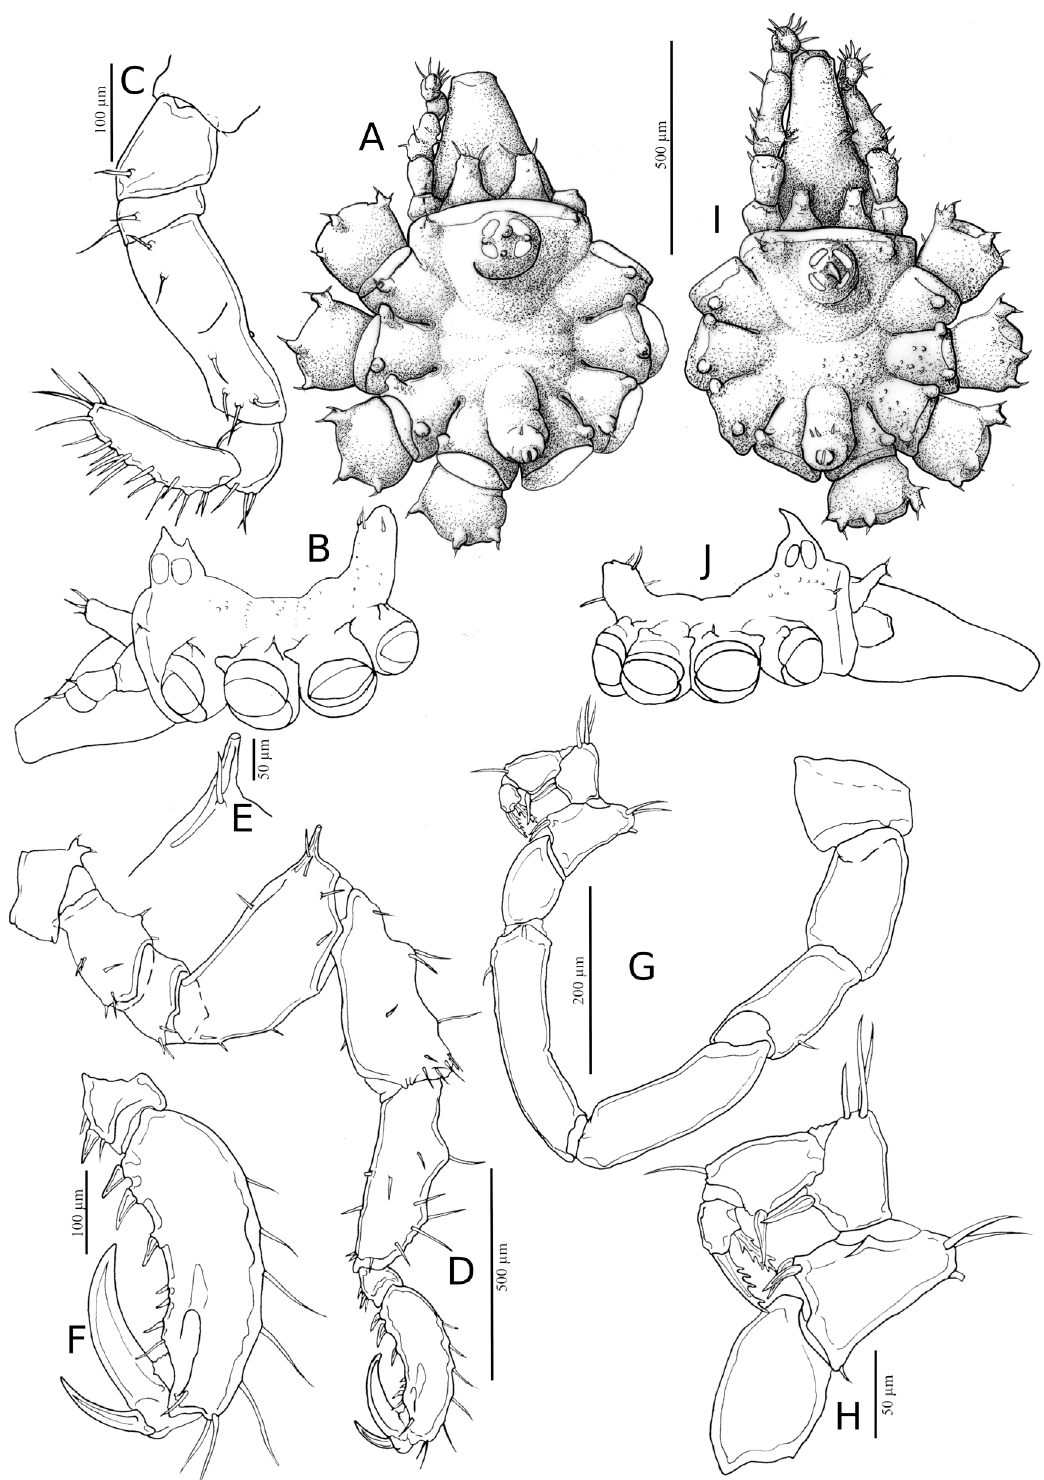
Fig. 5. Comparison between Tanystylum boucheti sp. nov. (A–H) and T. hummelincki Stock, 1954 (I– J). A–H . Holotype, ♂, MNHN-IU-2016-1074. I–J . ♂, MNHN-IU-2016-1063. A . Body, dorsal view. B . Body, lateral view (same scale as A). C . Palp. D . Third leg. E . Cement gland tube. F . Tarsus and propodus of third leg. G . Oviger. H . Oviger strigilis. I . Body, dorsal view. J . Body, lateral view. I and J same scale as